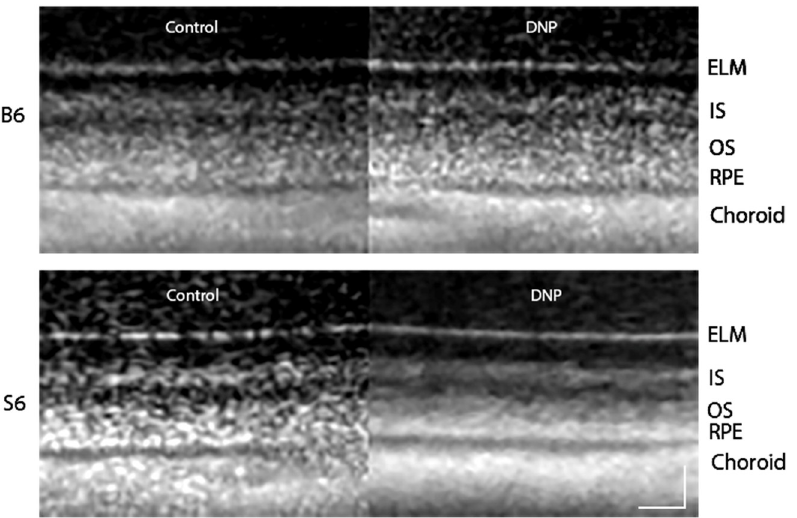
Fig 1. Representative same-eye OCT images focused on the superior outer retina layers for dark-adapted B6 and S6 mice before (Control) and after DNP treatment. Layer assignments are: ELM, external limiting membrane; IS, rod inner segment layer; OS, rod outer segment layer; RPE, retinal pigment epithelium, as reported earlier [37]. Scale bars, 20 μ m.